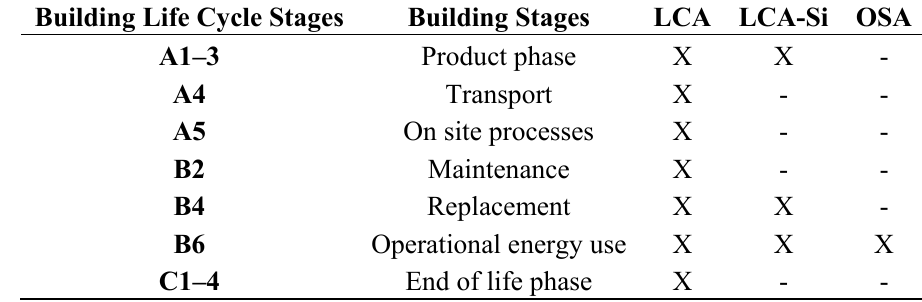
Table 2. Building Life Cycle Stages in relation to the three methods considered: Life Cycle Assessment (LCA), simplified LCA (LCA-Si) and Operational Stage Assessment